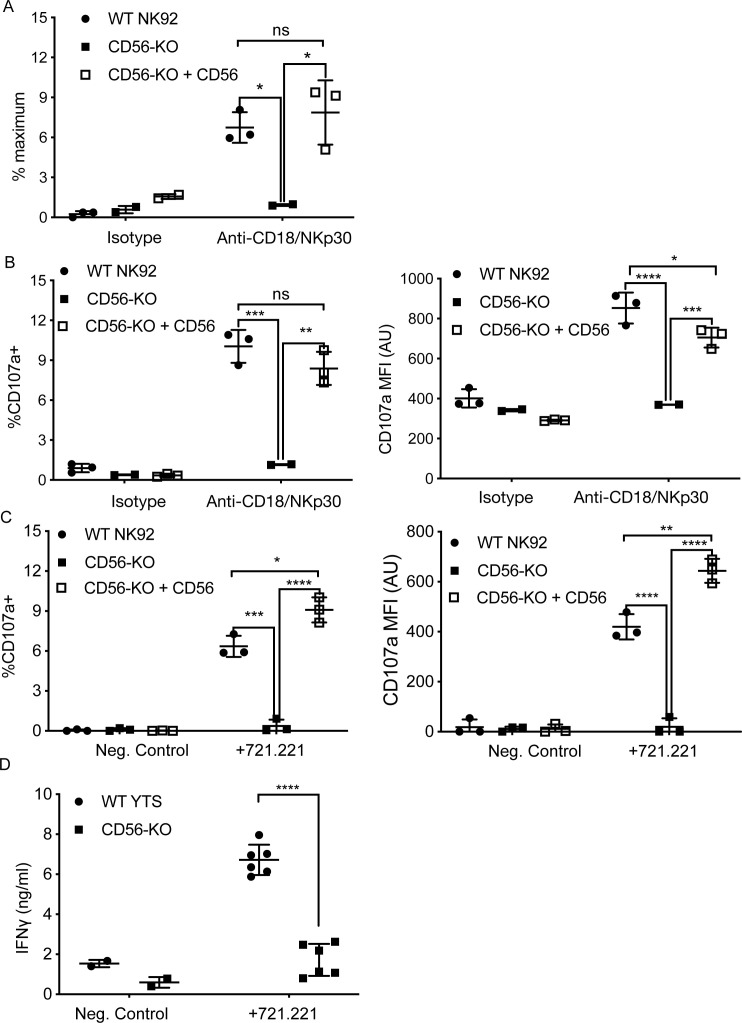
CD56 expression is required for exocytosis of NK92 cells.(A) WT NK92, CD56-KO or CD56-KO reconstituted cells were incubated for 60–90 min on plates pre-coated with 10 μg/ml of anti-CD18 and anti-NKp30 antibodies. Supernatant was collected and granzyme A secretion was measured by a BLT esterase assay. Secretory potential was measured as a readout of the % maximum of granzyme A activity in the supernatant. (B) WT NK92, CD56-KO or CD56-KO reconstituted cells were incubated for 1–2 hr on plates pre-coated with 10 µg/ml of anti-CD18 and anti-NKp30 antibodies. Cells were harvested and degranulation was measured by CD107a expression using flow cytometry. (C) WT NK92, CD56-KO or CD56-KO reconstituted cells were co-cultured with 721.221 target cells. Cells were harvested and CD107a expression was measured by flow cytometry. For co-culture experiments the average background of media only was subtracted from samples. Mean ± SD. *p<0.05, **p<0.01, ***p<0.001, ****p<0.0001 by one-way ANOVA with Tukey’s multiple comparisons post-hoc test. (D) WT YTS and CD56-KO cells were incubated with 721.221 target cells at a 2:1 ratio for 22 hr. Supernatant was collected and used in a human IFN gamma ELISA. ****p<0.0001 by unpaired student t-test with Welch’s correction. All data are representative of 3 independent experiments performed in duplicate or triplicate.